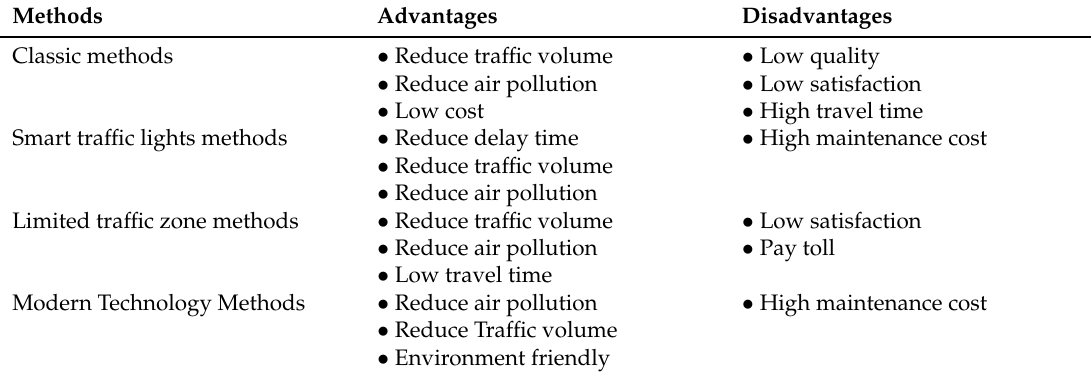
Table 1. Comparison of traffic control methods.